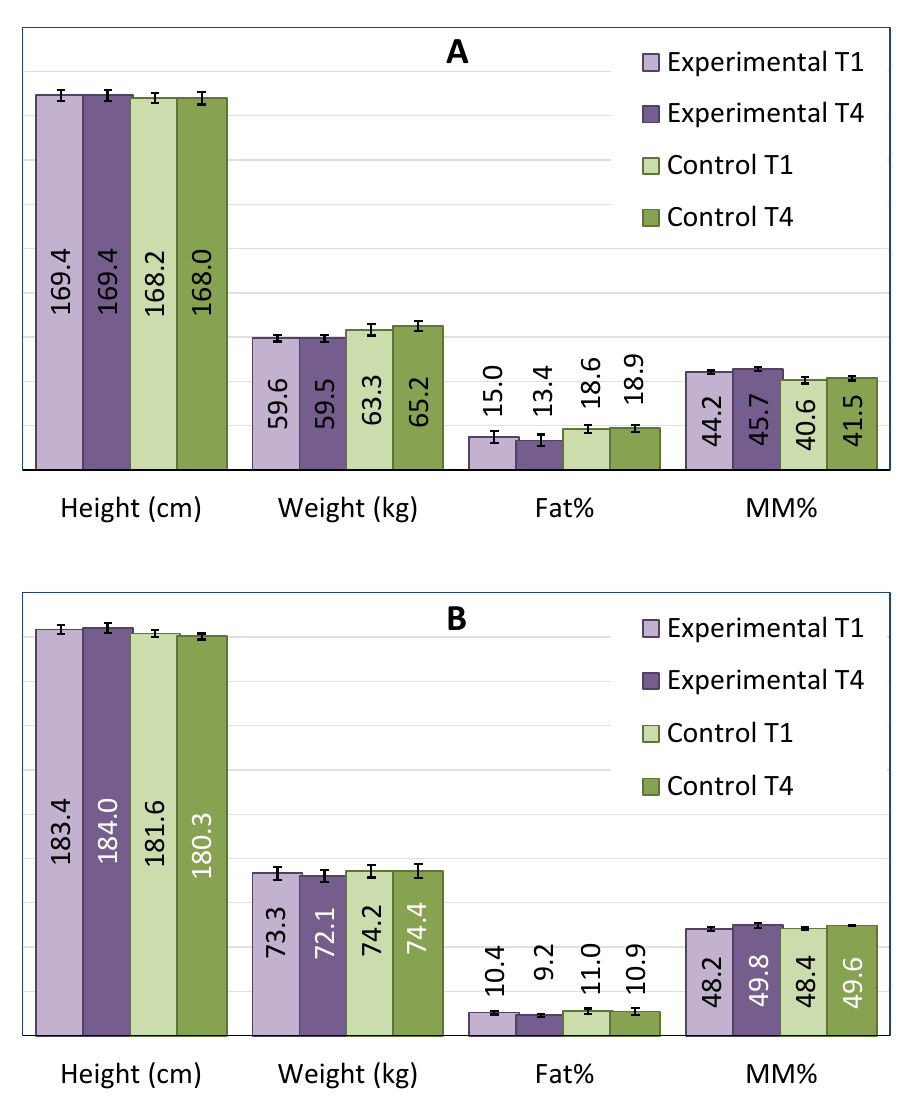
Figure 1. Anthropometric parameters of the female swimmers (A) and male swimmers (B) from the experimental and control groups on the 1 st (T1) and the 42 nd (T4) days of the six-week training